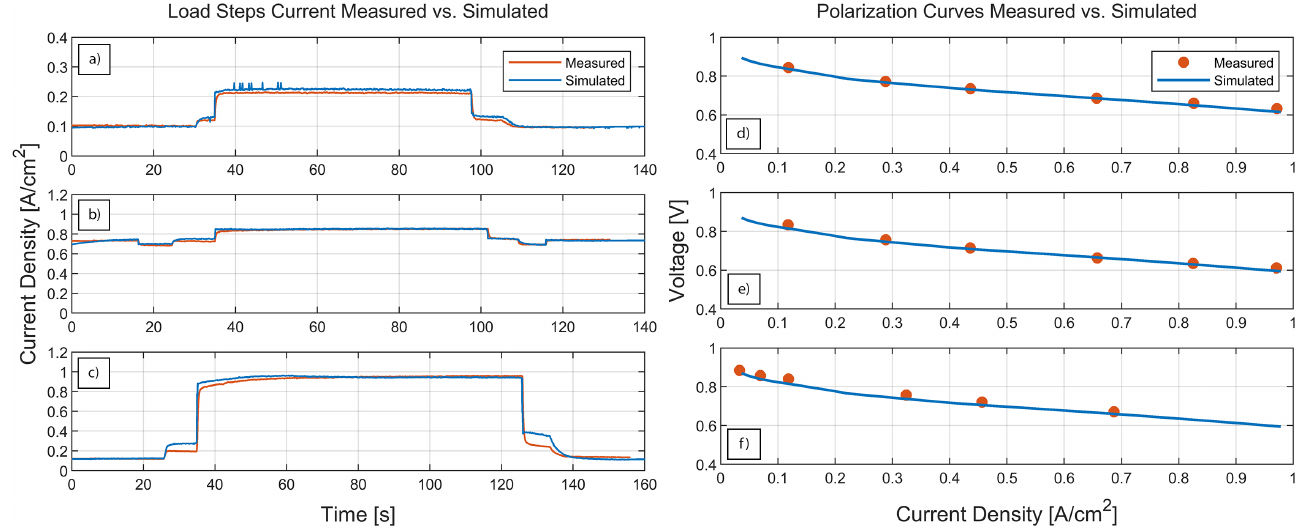
Figure 5. Comparison of measured and simulated current values with parameters obtained from optimization procedure. Load steps: ( a ) L1, ( b ) L2, ( c ) L3 and polarization curves: ( d ) P1, ( e ) P2, ( f ) P3. Simulated values show good agreement with measured